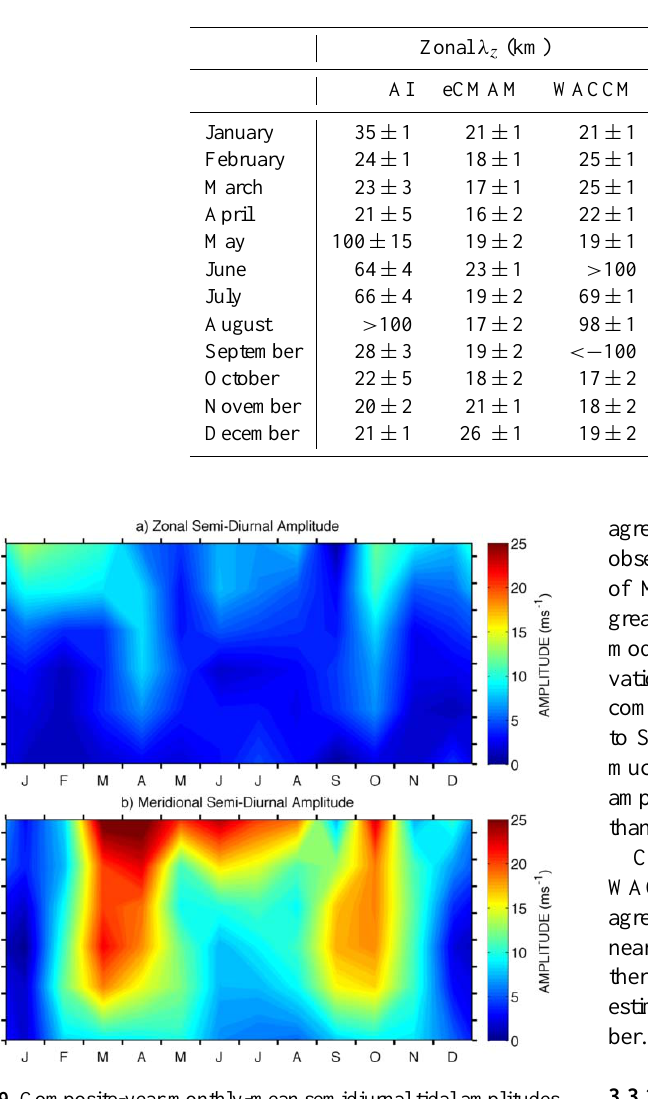
Fig. 9. Composite-year monthly-mean semidiurnal tidal amplitudes as a function of month and height over Ascension Island for all data recorded from January 2002 to June